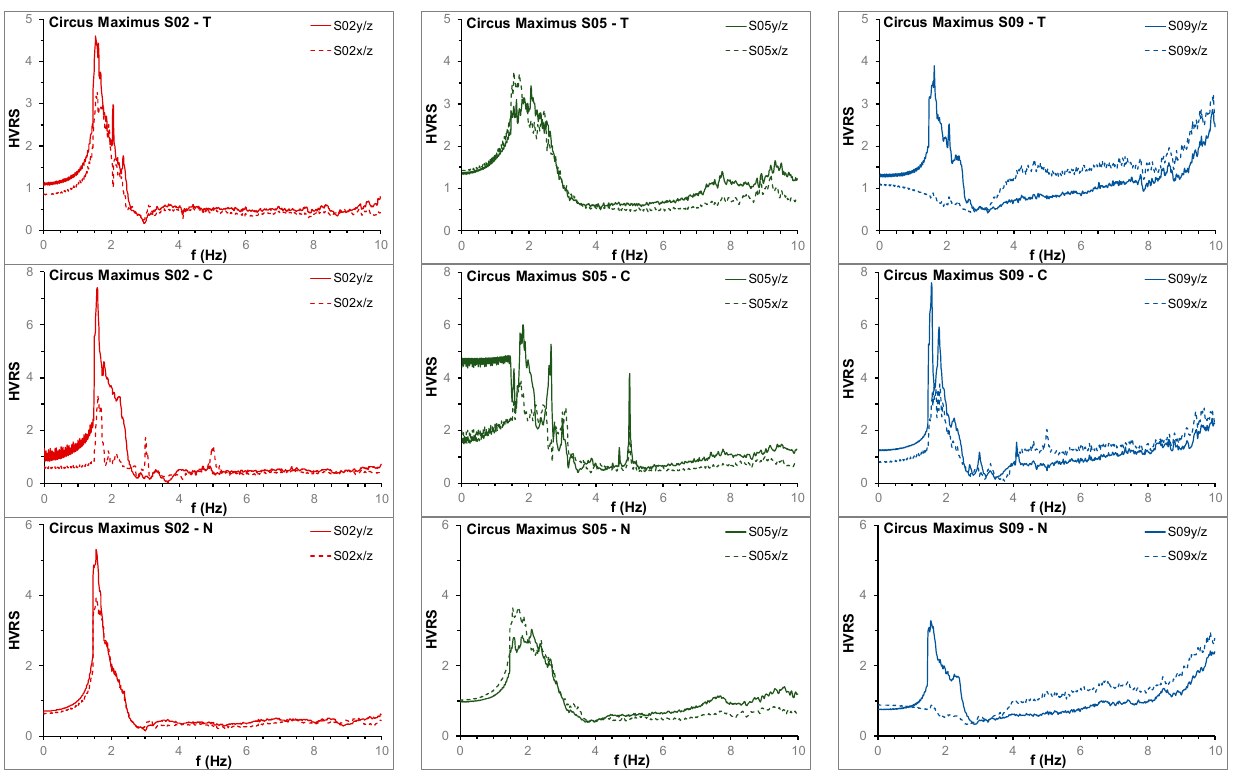
Figure 16. Circus: HVRS at S02, S05, and S09 in T, C, and N.